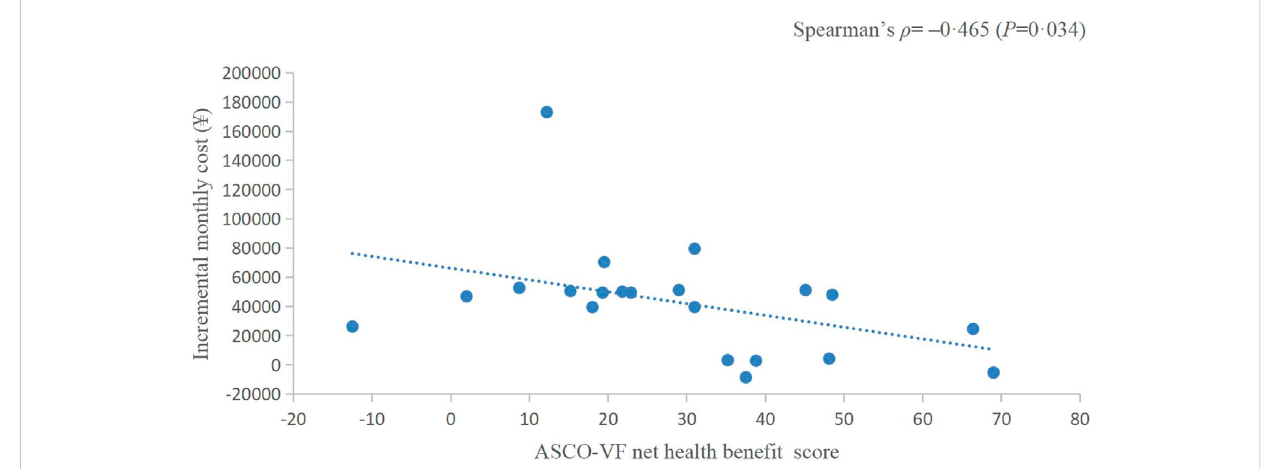
FIGURE 2 Scatterplot of the correlation between ASCO-VF net health bene fi t scores and incremental monthly cost.